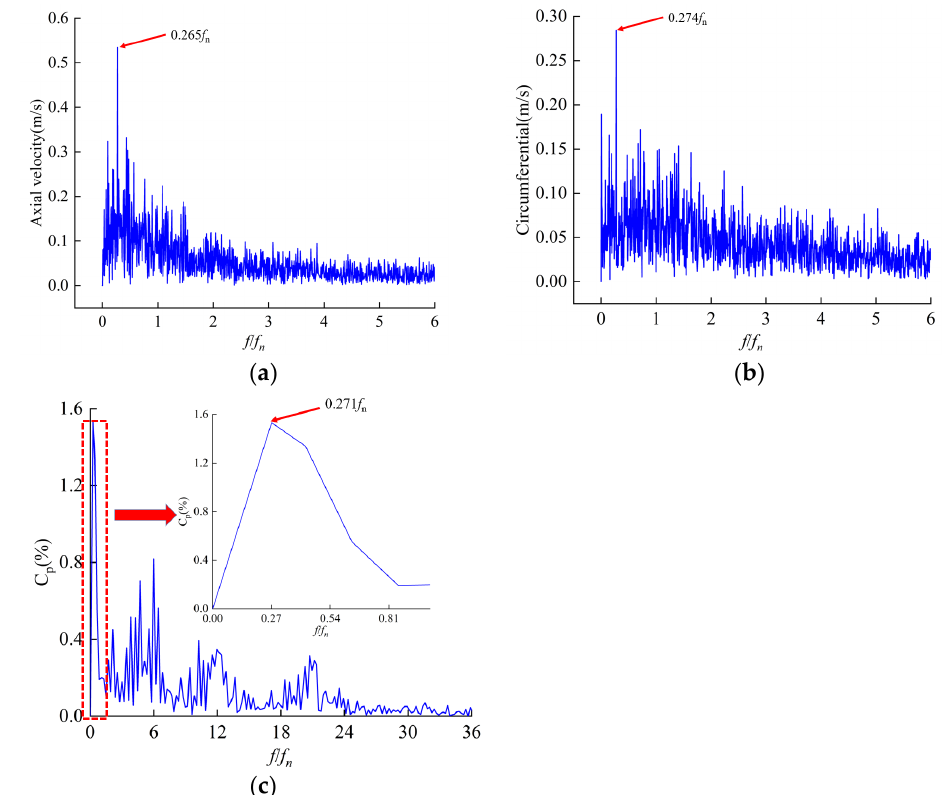
Figure 18. FFT result at OP1 (LDV measuring point position is 0.5 R). ( a ) axial velocity, ( b ) circumferential velocity, and ( c ) pressure pulsation.